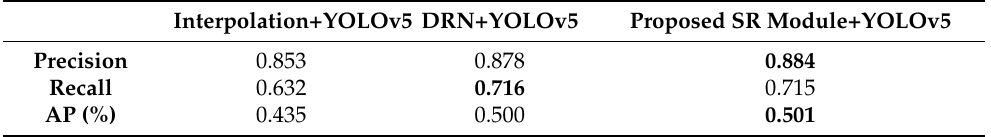
Table 3. Detection performance of different